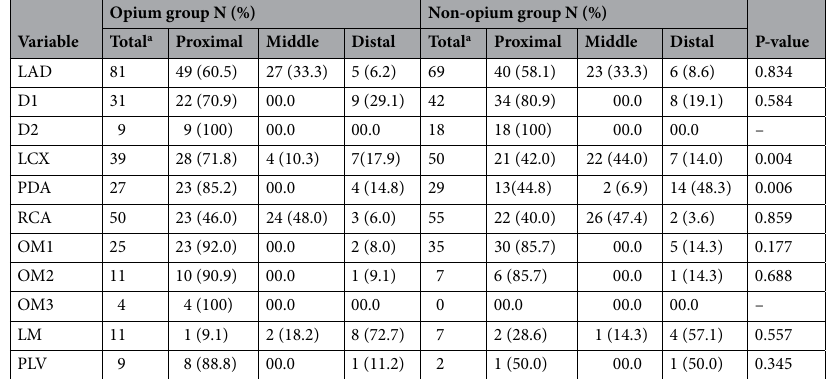
Table 3. The location of obstructive coronary artery involved segments in the non-opium and opium groups. LAD left anterior descending artery, D1 first diagonal artery, D2 second diagonal artery, LCX left circumflex artery, PDA patent ductus arteriosus, RCA right coronary artery, OM1 first obtuse marginal artery, OM2 second obtuse marginal artery, OM3 third obtuse marginal artery, LM left main artery, PLV posterior left ventricular artery. a The total number of involvements has been mentioned for each